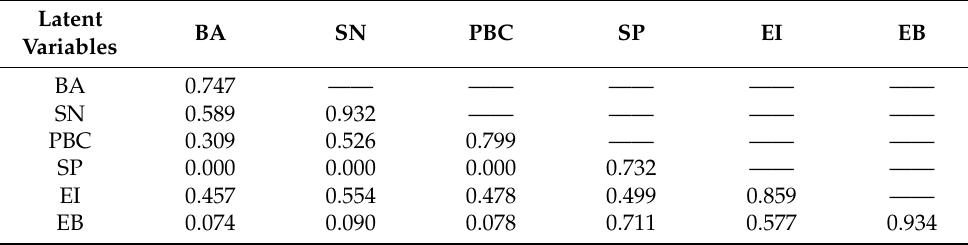
Table 4. Discriminant validity test of latent